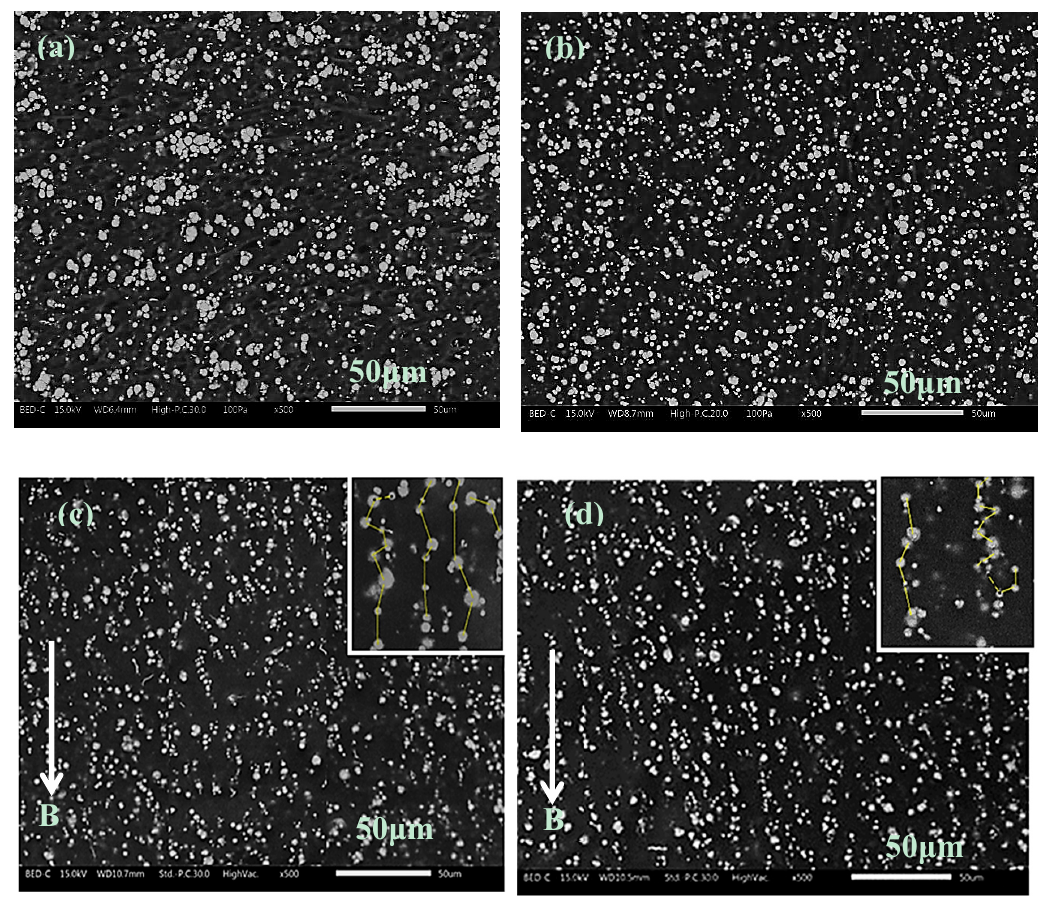
Figure 2. Fractured surface morphology of MREs: ( a ) isotropic MRE with 0 wt% SO and ( b ) isotropic MRE with 15 wt% SO; ( c ) anisotropic MRE with 0 wt% SO and ( d ) anisotropic MRE with 15 wt% SO.